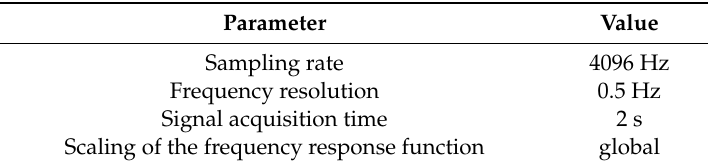
Figure 3. Diagram of the test stand for determining the loss factor ( a ) and analyzed beam ( b ). Table 1. Parameters of signal acquisition.